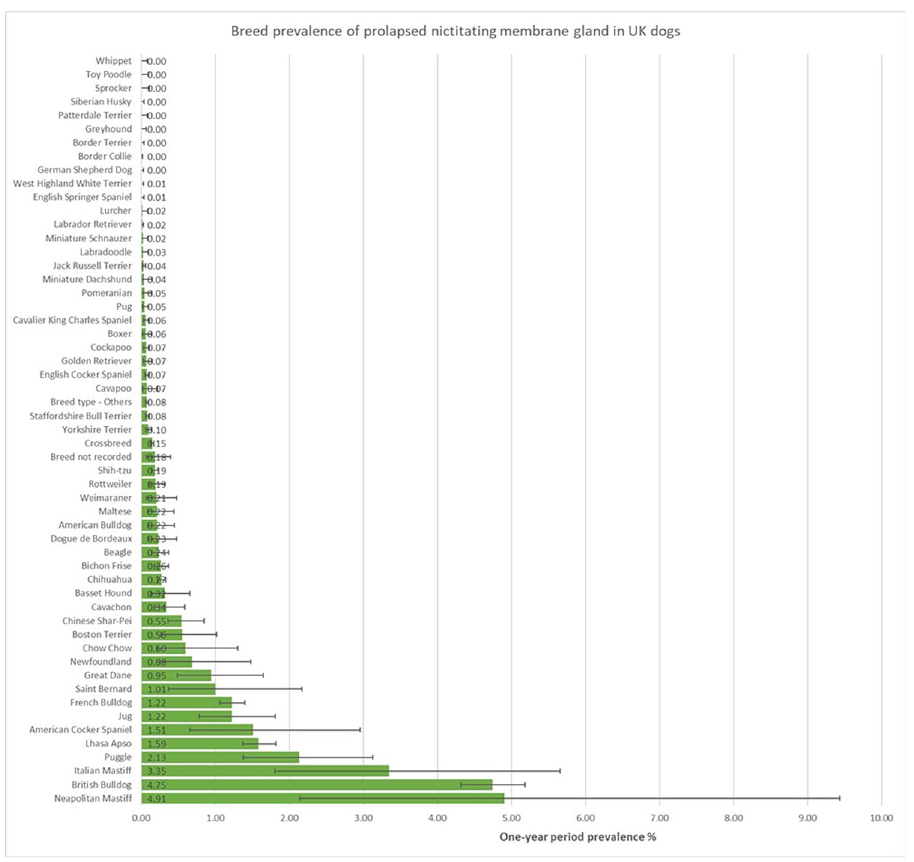
Fig 1. One-year (2016) period prevalence (percentage) of prolapsed nictitating membrane gland (PNMG) in dog breeds under primary veterinary care in the VetCompass ™ Programme in the UK. The horizontal bars represent 95% confidence